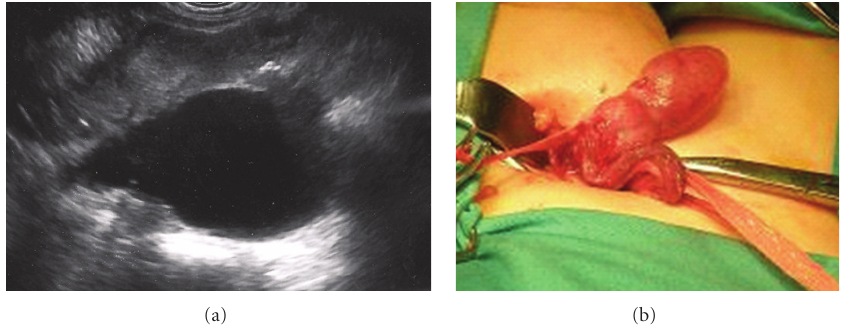
Figure 2: (a) Ultrasonic and (b) intraoperative images: the paratesticular mass, found to be an epididymal cyst was excised.